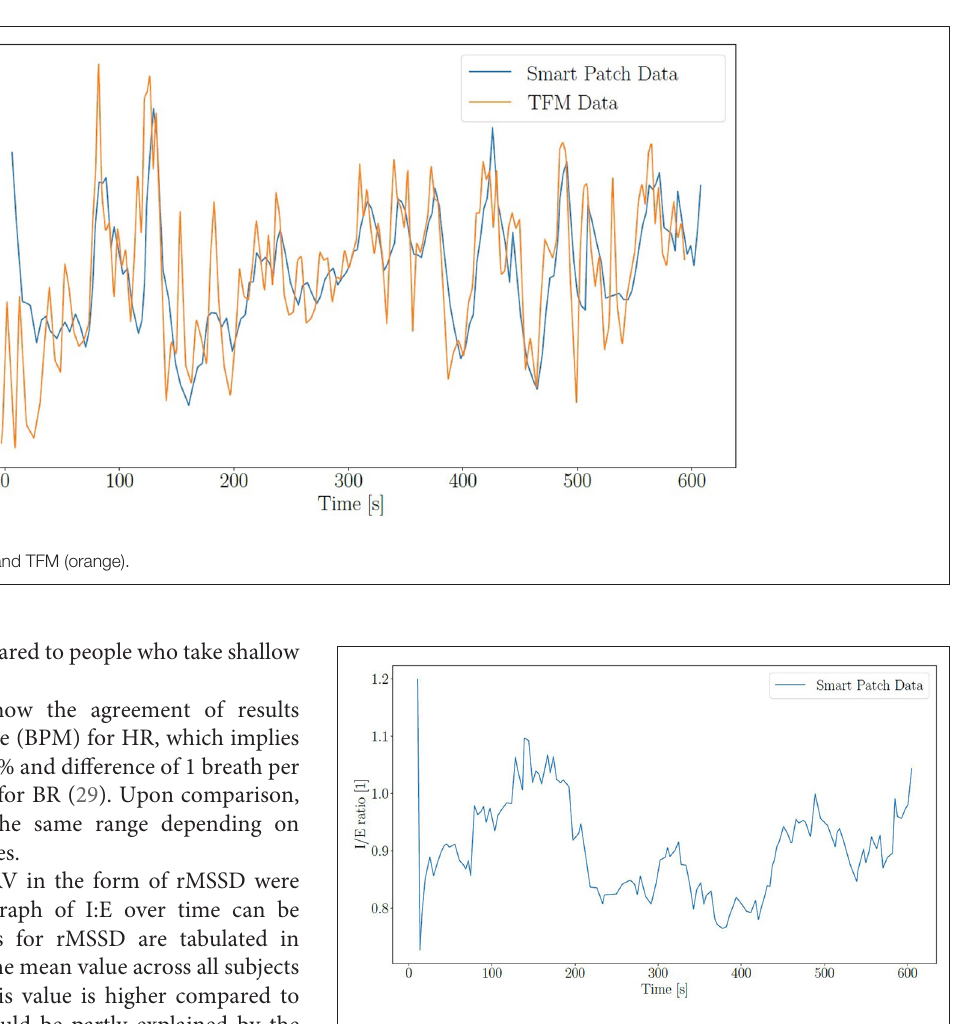
FIGURE 6 | I:E for subject 1 at position